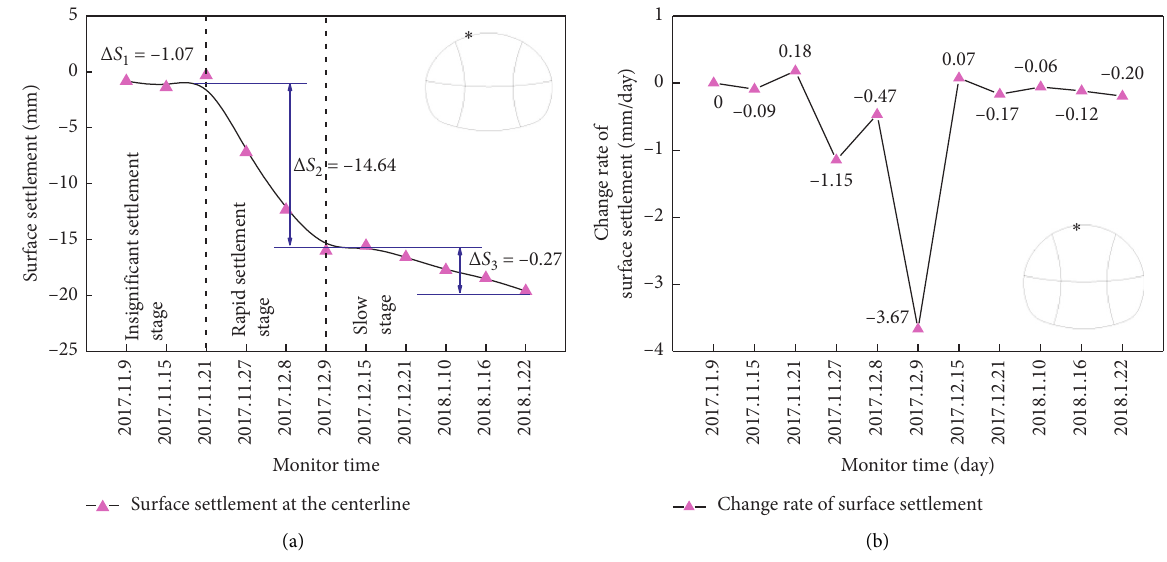
Figure 17: Variation characteristics of the time-history curve of surface settlement. (a) Time-history curve of surface settlement. (b) Change rate of surface